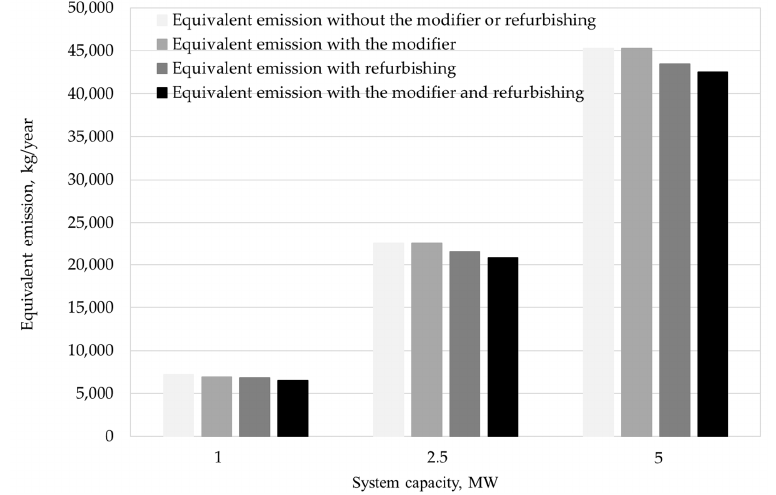
Figure 7. Equivalent emission (SO 2 , NO 2 and particulate matter) in fuel oil combustion for system capacities from 1 MW to 5 MW.